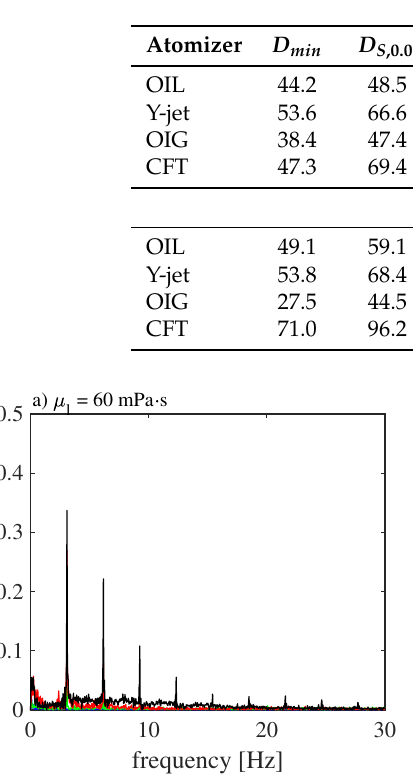
Figure 11. Power spectra of time-dependent drop sizes for spraying at GLR = 5%.